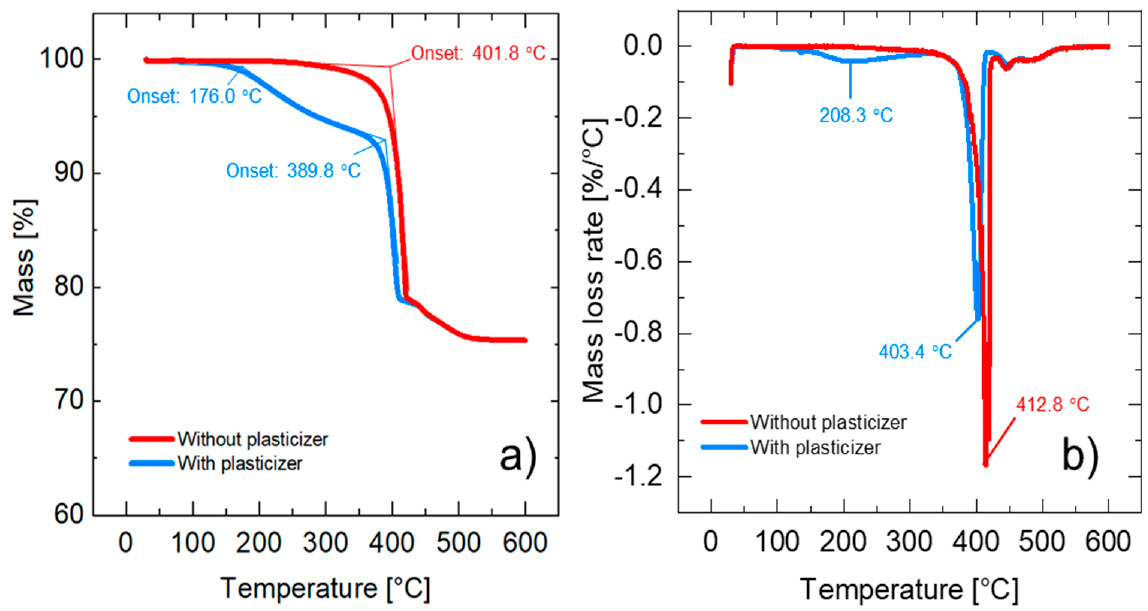
Figure 5. TGA measurements of ABSc with and without plasticizer (10 °C/min, Oxygen): ( a ) Mass loss [%] vs. temperatures [°C]; ( b ) mass loss rate [%/°C] vs. temperature